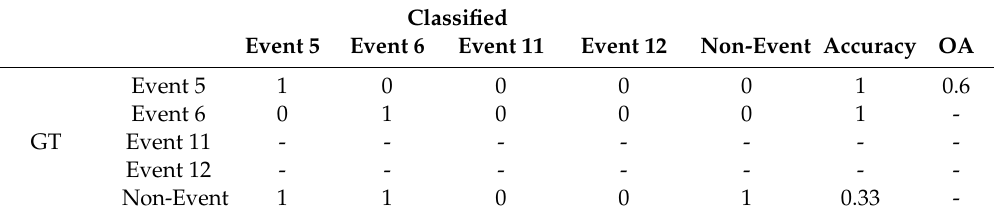
Event classification using the hybrid approach for one VIRAT video: